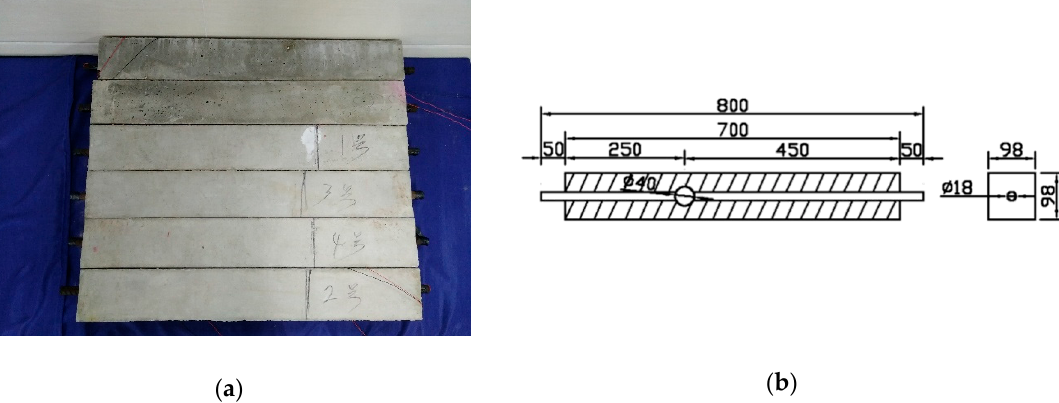
Figure 6. The detecting concrete sample. ( a ) The physical feature of reinforced concrete specimens. ( b ) 3D transparent feature of the sample (mm).